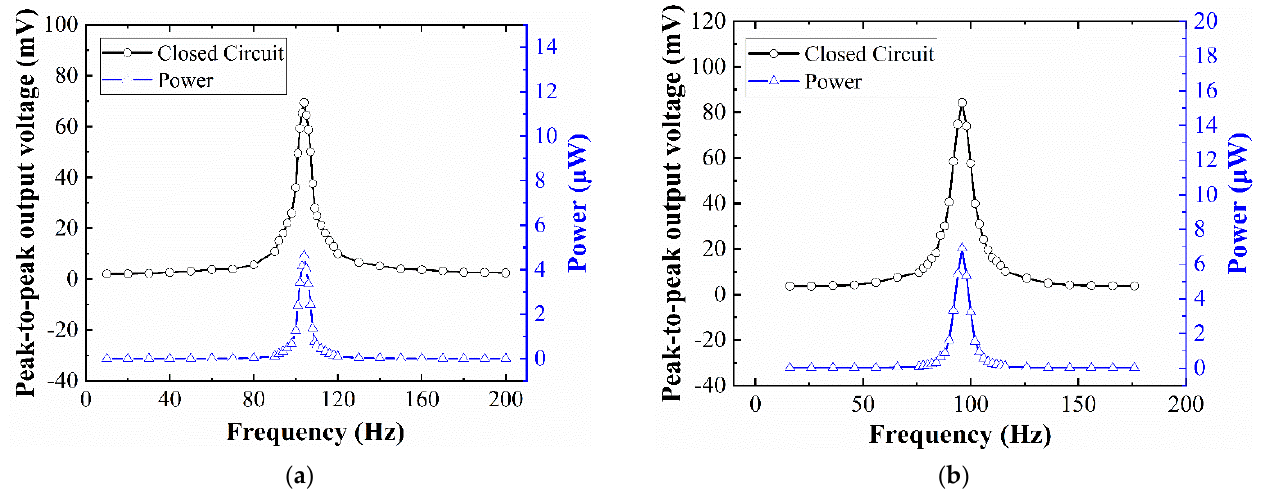
Figure 10. The peak-to-peak closed-circuit output voltage and power of the EVEH device as a function of frequency: ( a ) T1 device; ( b ) T2 device.